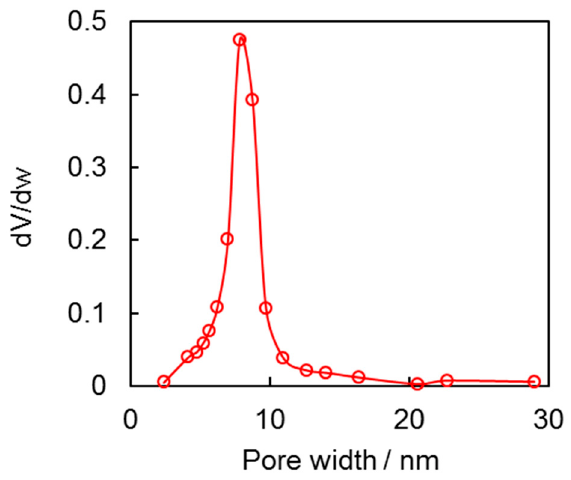
Figure 4. Pore size distribution of the synthesized